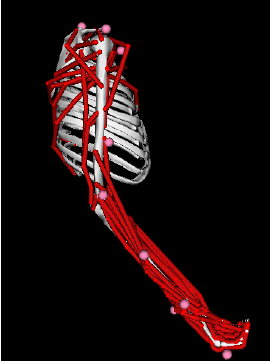
Figure 3. OpenSim upper limb musculoskeletal model. This model was developed by Saul et al. [19]. It consists of 7 body segments and 32 muscles across the shoulder, elbow, forearm, and wrist. The muscle kinematics parameters and experimental joint moment can be obtained through this musculoskeletal model.